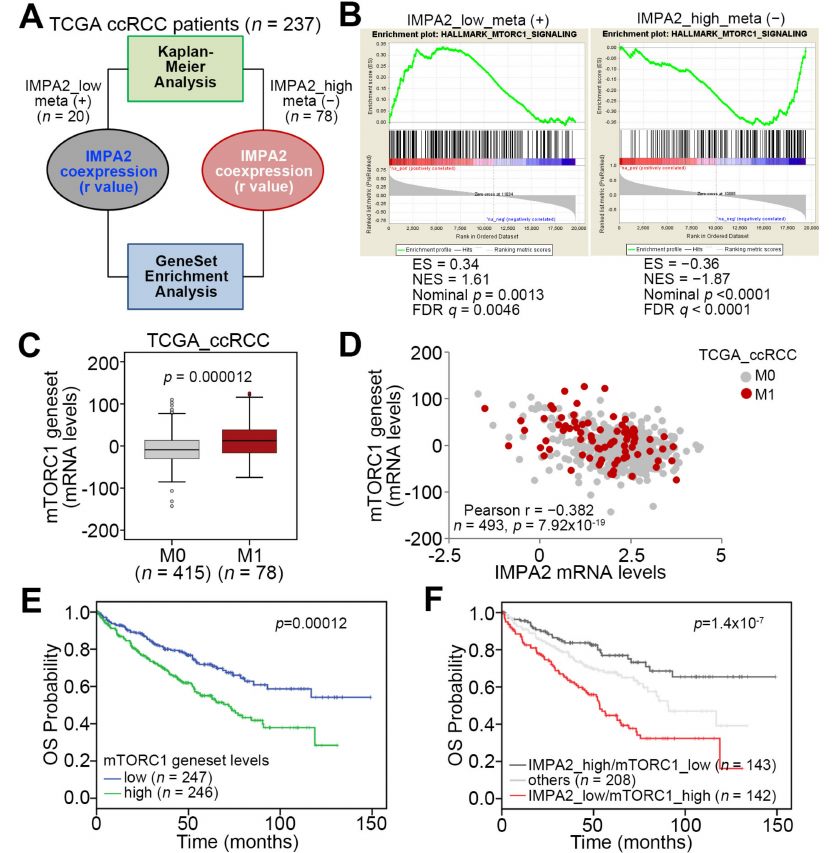
Figure 1. Inositol monophosphatase 2 (IMPA2) downregulation probably correlates with an increased activity of the mTORC1-related pathway and the metastatic progression of clear cell renal cell carcinoma (ccRCC). ( A ) Flowchart for the generation of Pearson correlation coe ffi cient (r) values for the IMPA2 co-expression with somatic genes in the ccRCC tissues derived from the two grouped The Cancer Genome Atlas (TCGA) ccRCC patients in order to perform the computational simulation by gene set enrichment analysis (GSEA) program. The features of two grouped TCGA ccRCC patients are shown in Materials and Methods. ( B ) GSEA plots of Hallmark_mTOC1_signalnig in the IMPA2 co-expression signatures derived from metastatic ccRCC with low-level IMPA2 or non-metastatic ccRCC with high-level IMPA2. ( C ) Boxplot for the mRNA levels of mTORC1 gene set in TCGA ccRCC with pathologic M0 or M1 stage. The band inside the box is the second quartile (the median). The upper and lower lines of the box are the third and first quartiles, respectively. Box plots have lines extending vertically from the whiskers. indicating minimum and maximum of all of the data. The individual points indicate outliers. The significant di ff erence was analyzed by an independent sample t-test. ( D ) Scatchard plot for IMPA2 and mTORC1 gene set mRNA levels from the TCGA ccRCC database. Pearson’s correlation test was used to determine the statistical significance of IMPA2 and mTORC1 gene set co-expression in TCGA ccRCC with pathologic M0 or M1 stage. ( E and F ) Kaplan–Meier analyses for mTORC1 gene set mRNA levels ( E ) or the signatures of combined IMPA2 and mTORC1 gene set mRNA levels ( F ) in TCGA ccRCC patients. Others denote the signatures of IMPA2_high / mTORC1_high and IMPA2_low / mTORC1_low. The high and low expression levels of IMPA2 and mTORC1 gene set were determined by the median of their mRNA levels in primary tumors from the TCGA ccRCC